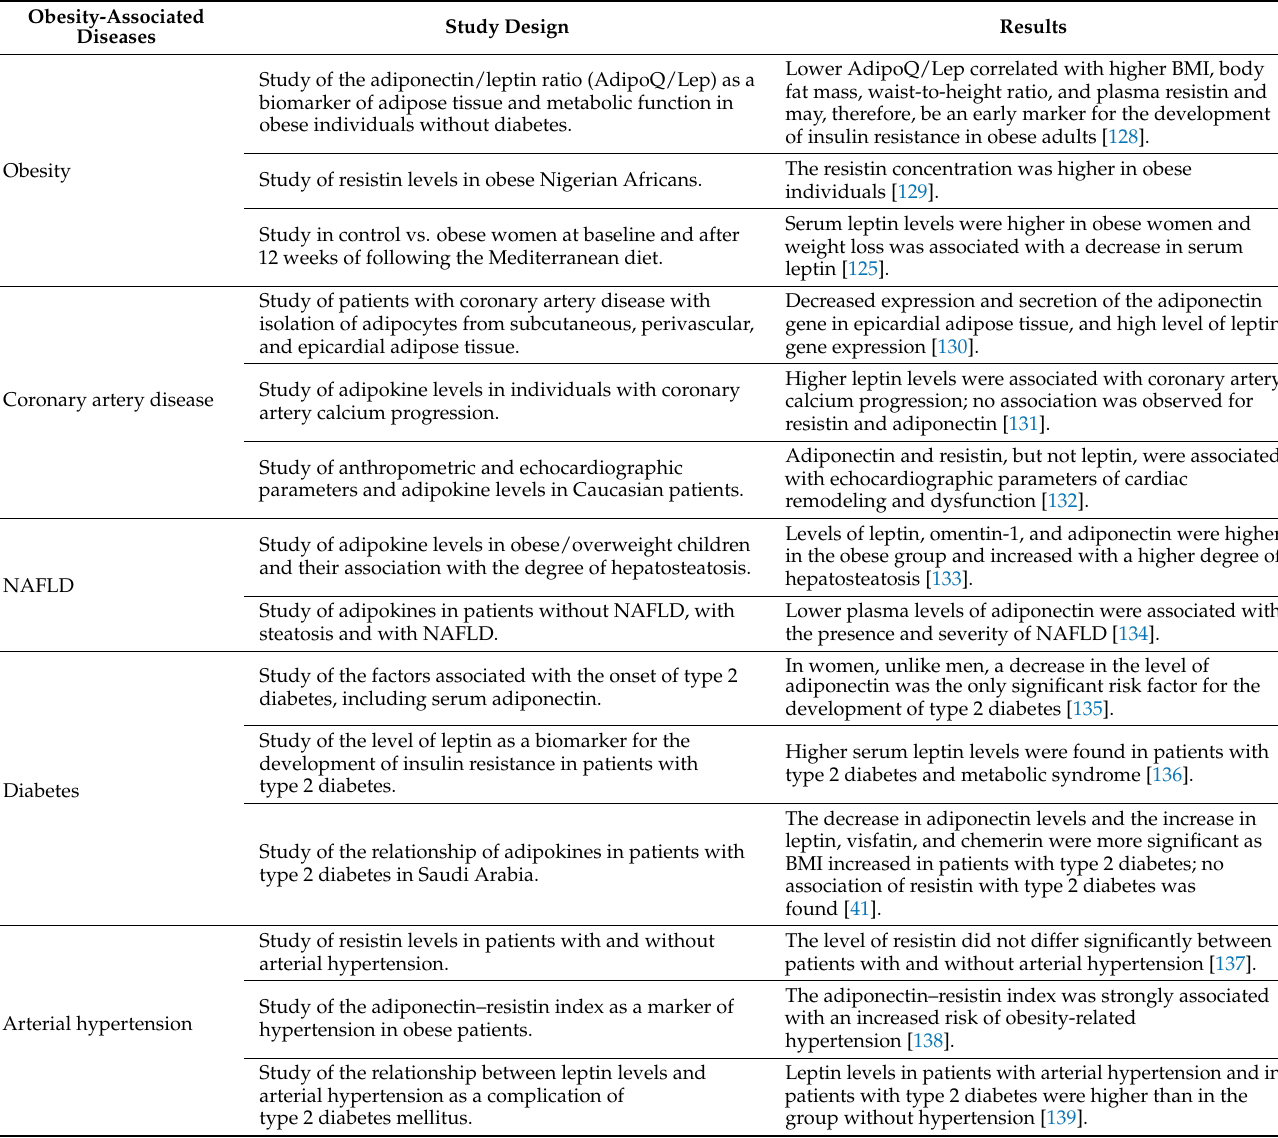
Table 1. Association of adipokine levels with obesity and associated